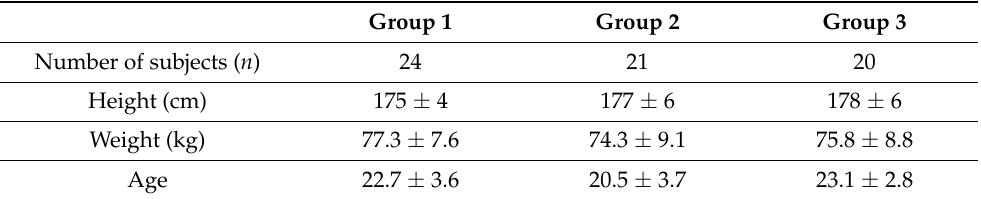
Table 1. Subjects